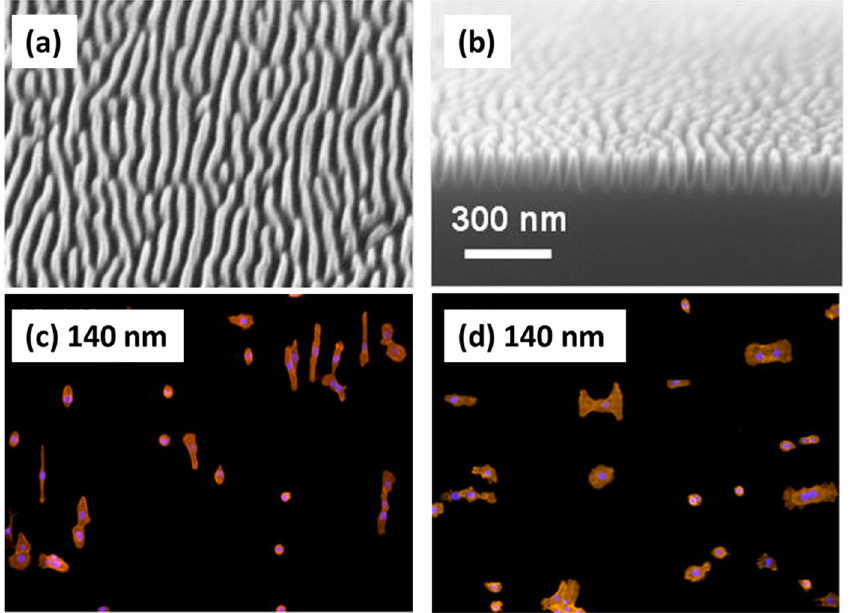
Figure 6. ( a , b ) SEM images of rippled substrates with 90 nm periodicity. ( a ) Top view. ( b ) Cross- sectional view. ( c , d ) Fluorescence images of HCEC showing ( c ) parallel alignment in epithelial growth medium and ( d ) perpendicular alignment in EpiLife ® medium on 140 nm ripple patterns. Reprinted from Ref. [124] with permission from Elsevier.